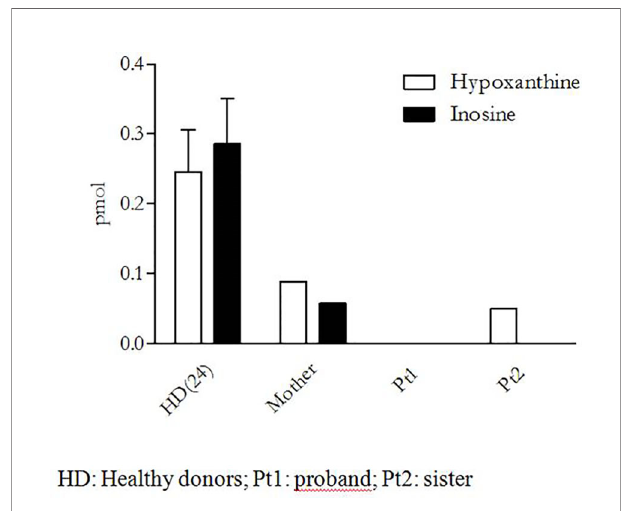
FIGURE 3 | Functional assay of ADA2